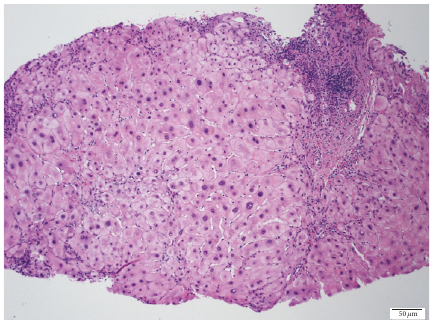
Figure 2: Liver biopsy showing nodules and fibrous septa associ- ated with effacement of lobular architecture in Hematoxylin-Eosin staining.